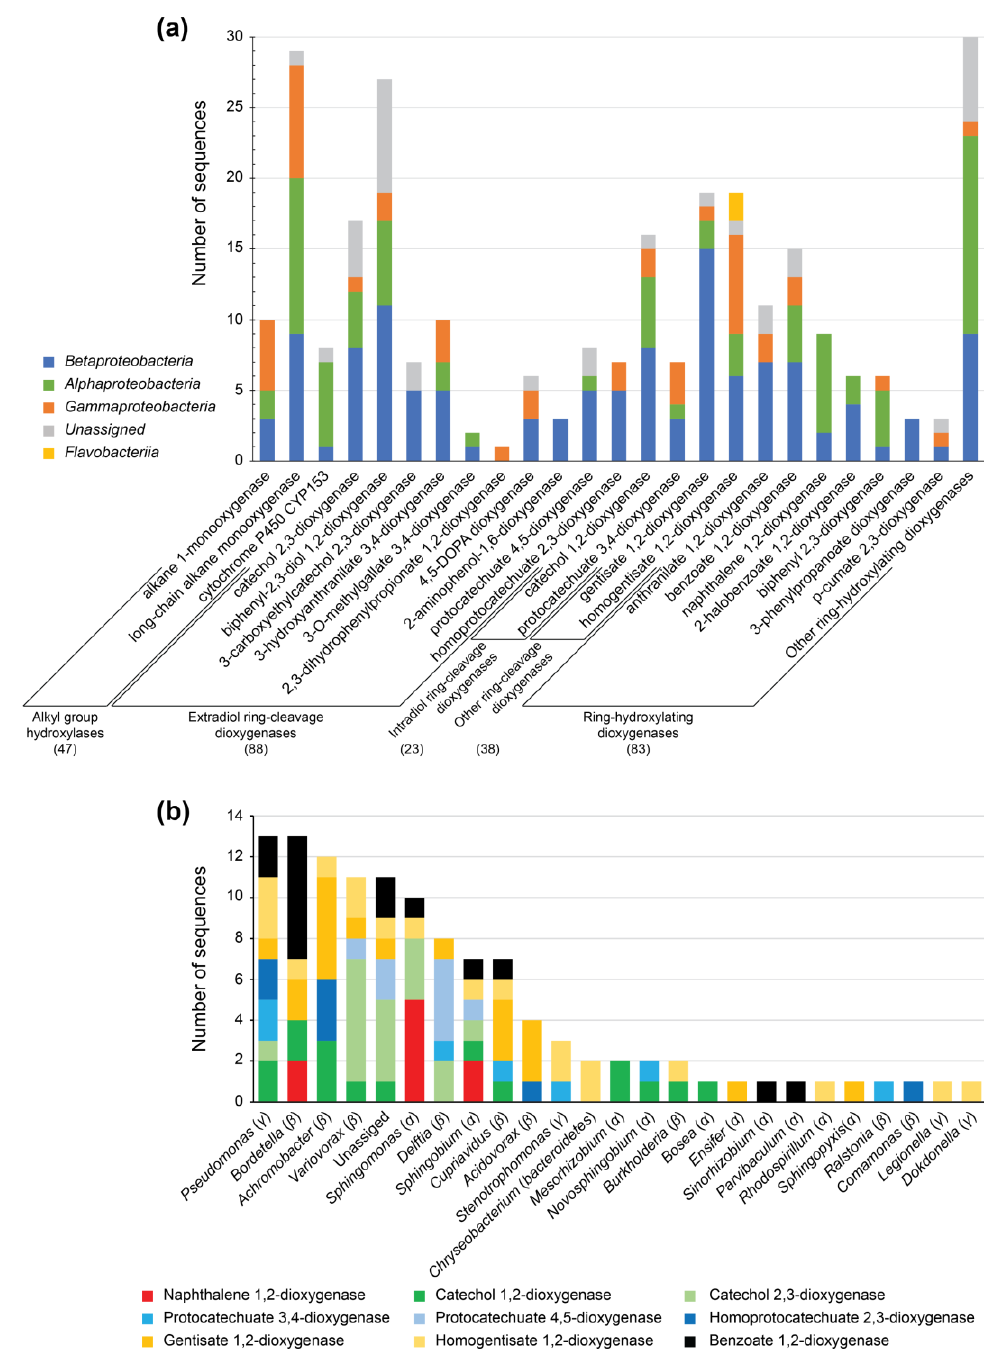
Figure 3. ( a ) Number and taxonomic assignation at the class level of the enzymes belonging to alkanes, PAHs and aromatic metabolism pathways. Total sequences of each main protein groups are indicated in parenthesis. ( b ) Classification at the genus level of naphthalene 1,2-dioxygenase and other central aromatic biodegradation pathways involving catechol, protocatechuate, gentisate, and benzoate. For additional information, see Supplementary Table S3.